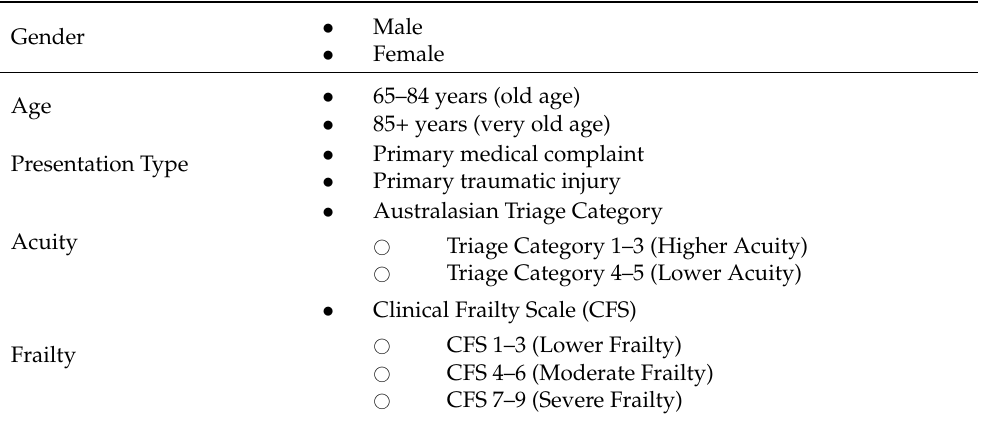
Table 2. Purposive Sampling